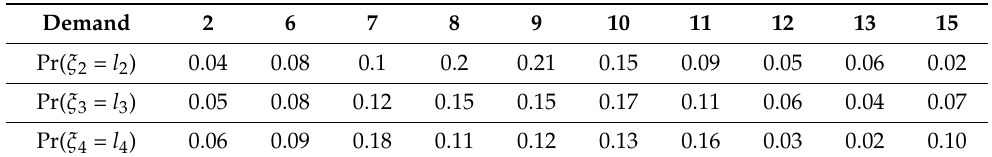
Table 13. Stages 2, 3 and 4 demand distribution (Pr( ξ 2 = i ), Pr( ξ 3 = i ) and Pr( ξ 4 = i )) forecast in